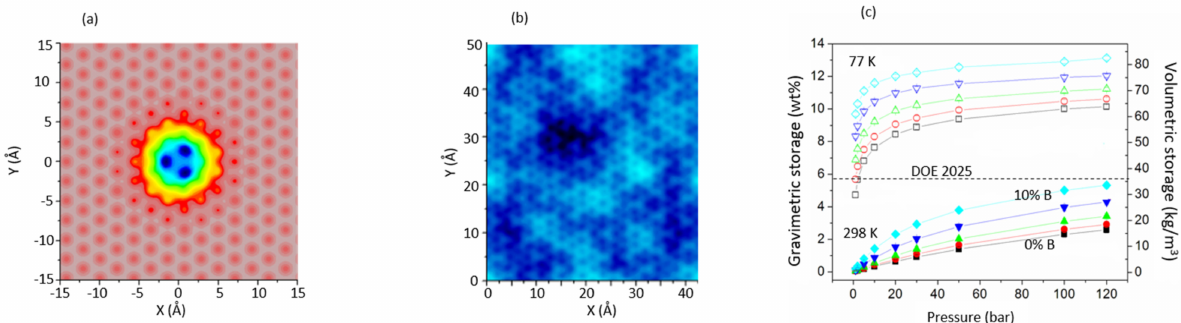
Figure 5. ( a ) Energy landscape for H 2 adsorption over graphene layer with central carbon atom substituted by boron; ( b ) energy landscape for H 2 adsorption over graphene layer containing 10% of substitutional boron atoms: the substitution is made at random, respecting the separation of two carbon sites between each pair of boron atoms; ( c ) gravimetric (left axis) and volumetric (right axis) storage capacity of boron substituted infinite slit pores as a function of H 2 pressure, for different B:C substitution